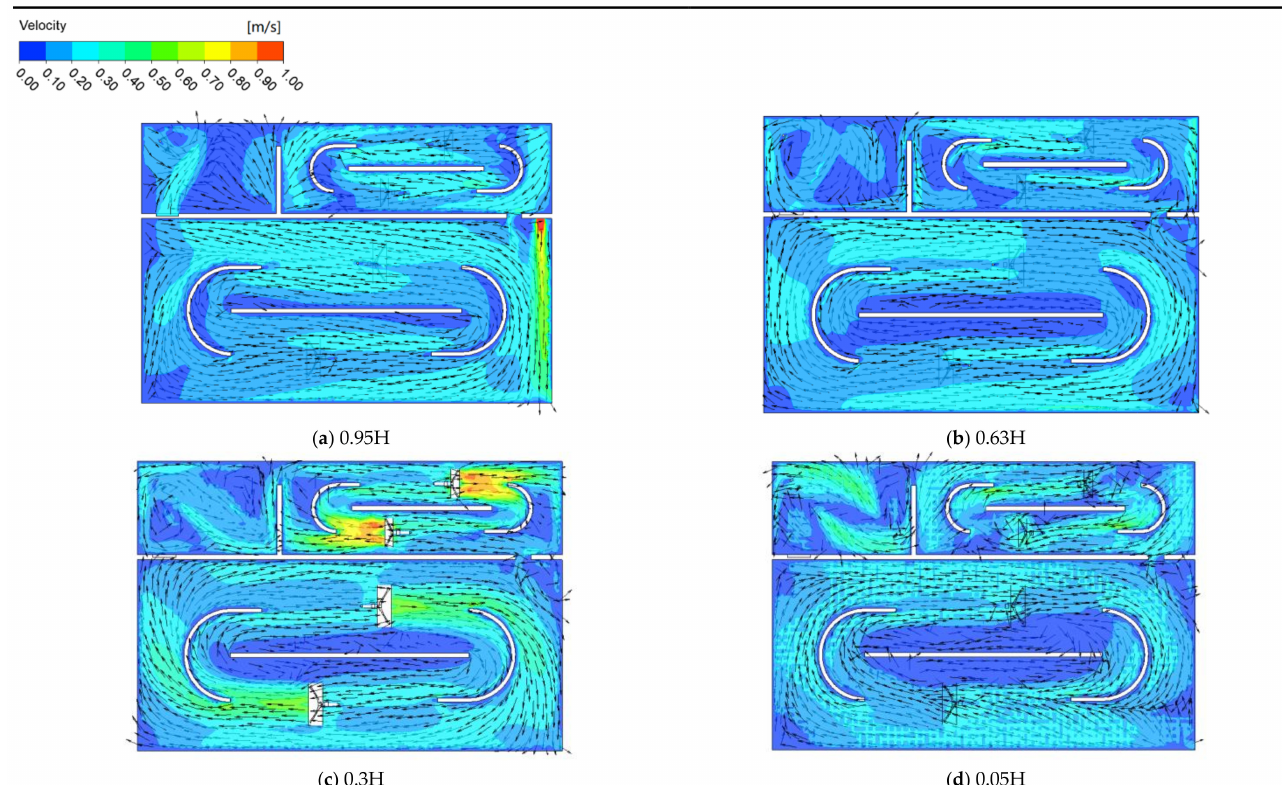
Figure 5. Velocity distribution in the OD at the X-Y cross sections: ( a ) 0.95 H, ( b ) 0.63 H, ( c ) 0.3 H, ( d ) 0.05